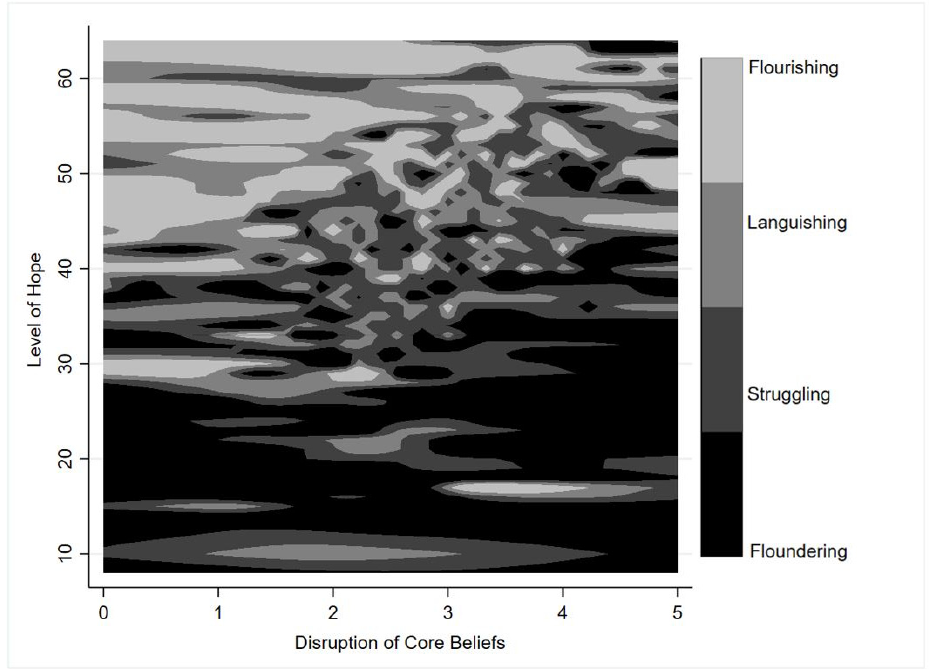
Figure 6. Level of hope and disruption of core beliefs by mental health state during the COVID-19 pandemic. Top left-hand corner corresponds to high levels of hope and low disruption of core beliefs. Bottom right-hand corner corresponds to low levels of hope and high disruption of core beliefs. Greyscale represents the four mental health states. Associations between hope, disruption of core beliefs, and mental health state during the COVID-19 pandemic are shown in Table 7. Each unit increase in hope score was asso- ciated with 10%, 15%, and 24% less risk of Languishing, Struggling, and Floundering,